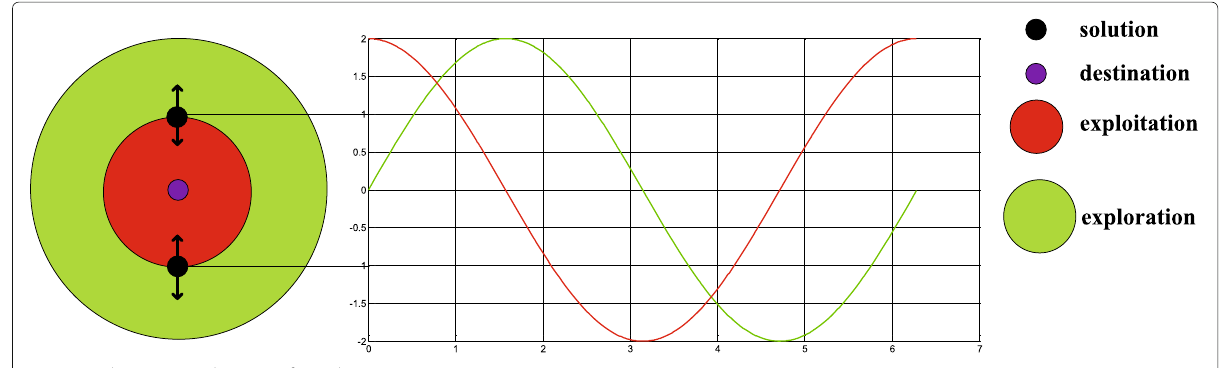
Fig. 2 Updating toward or away from destination